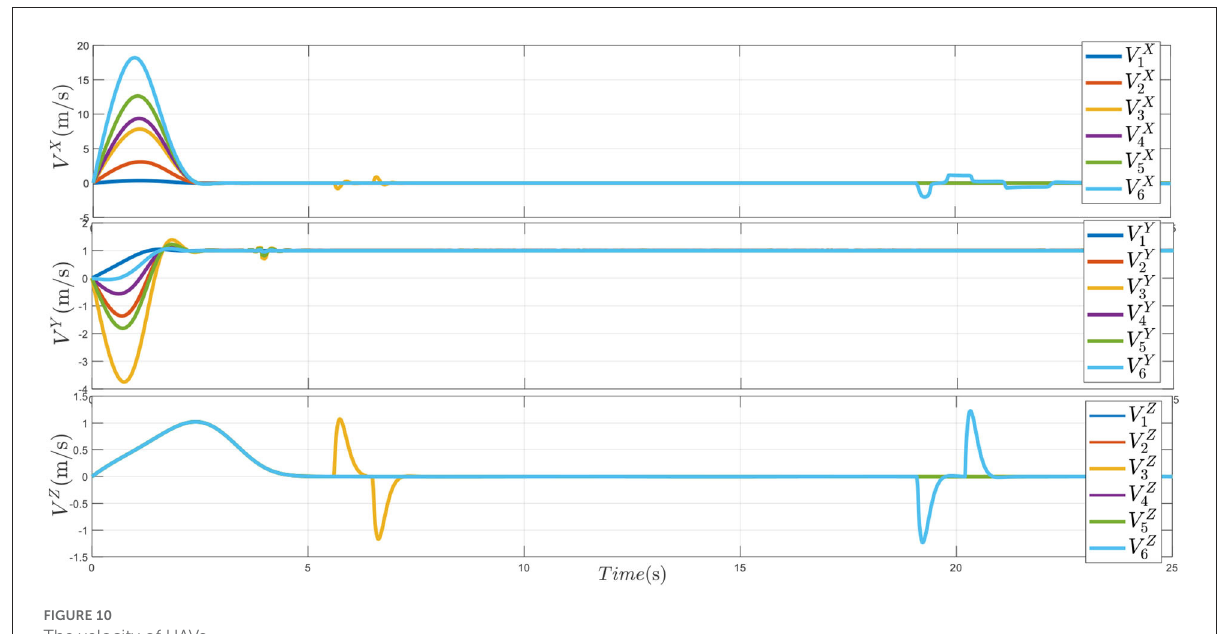
FIGURE10 The velocity of